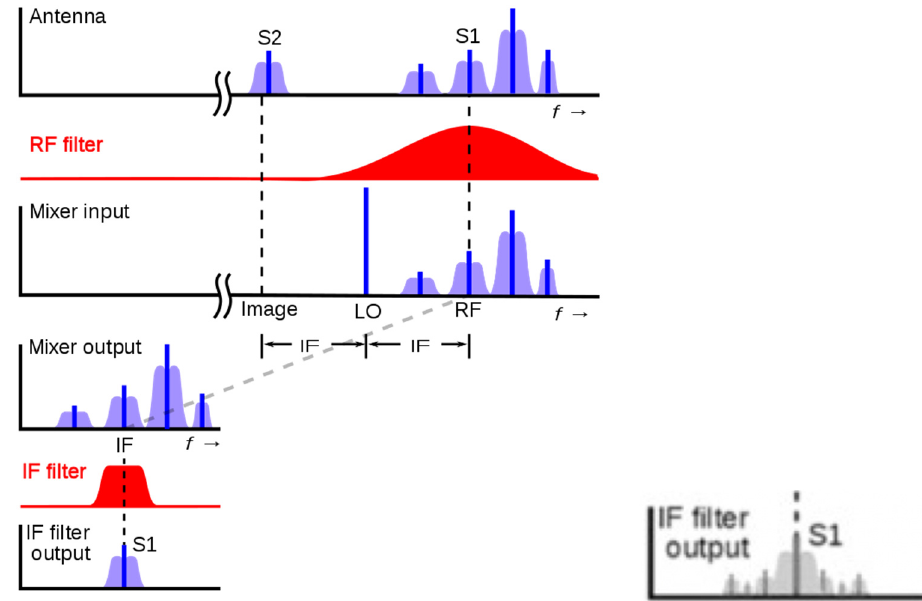
Figure 2. Operation mode in presence of an SEU ( right ) and without SEU ( left ).